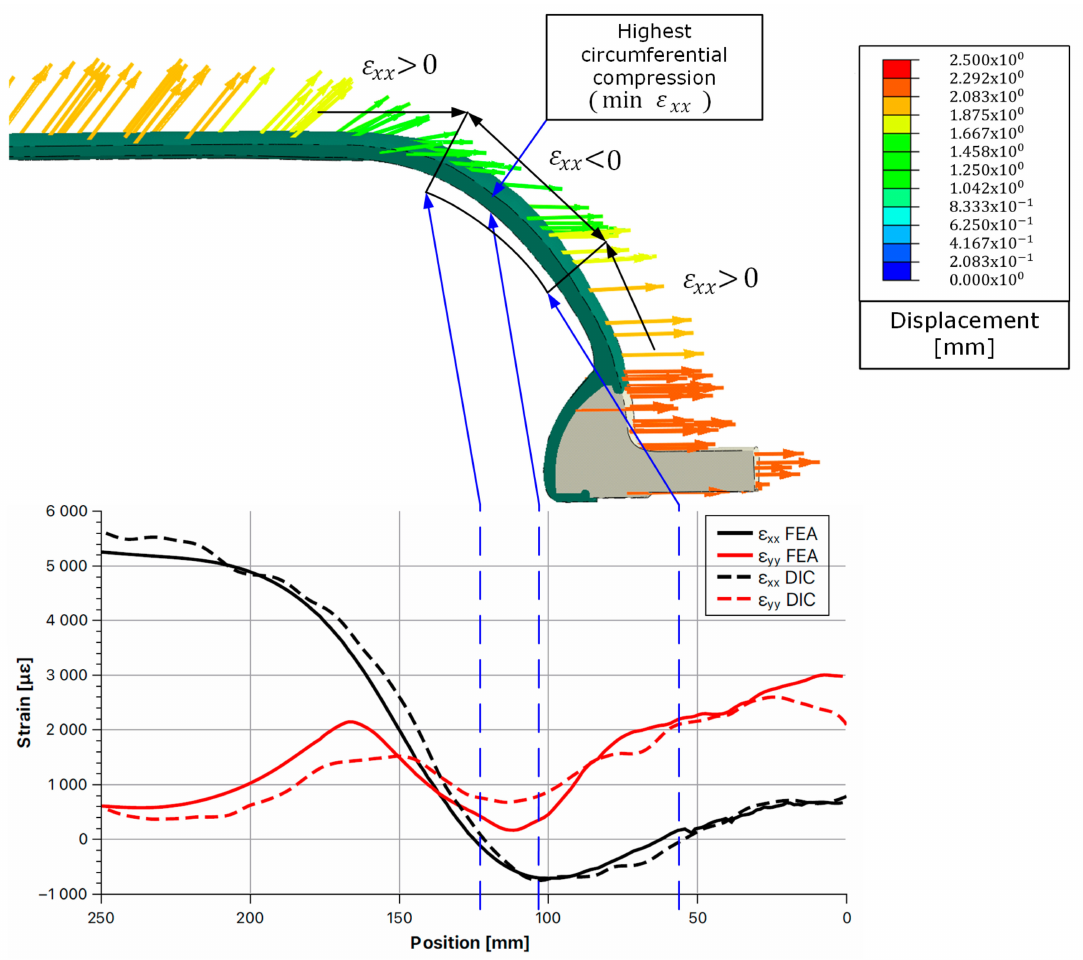
Figure 13. Strain in circumferential ( ε xx ) and longitudinal ( ε yy ) directions along the generating line using the DIC and FEM methods. Location of negative ε xx area marked with arrows. Displacement of the liner shows collapse around this